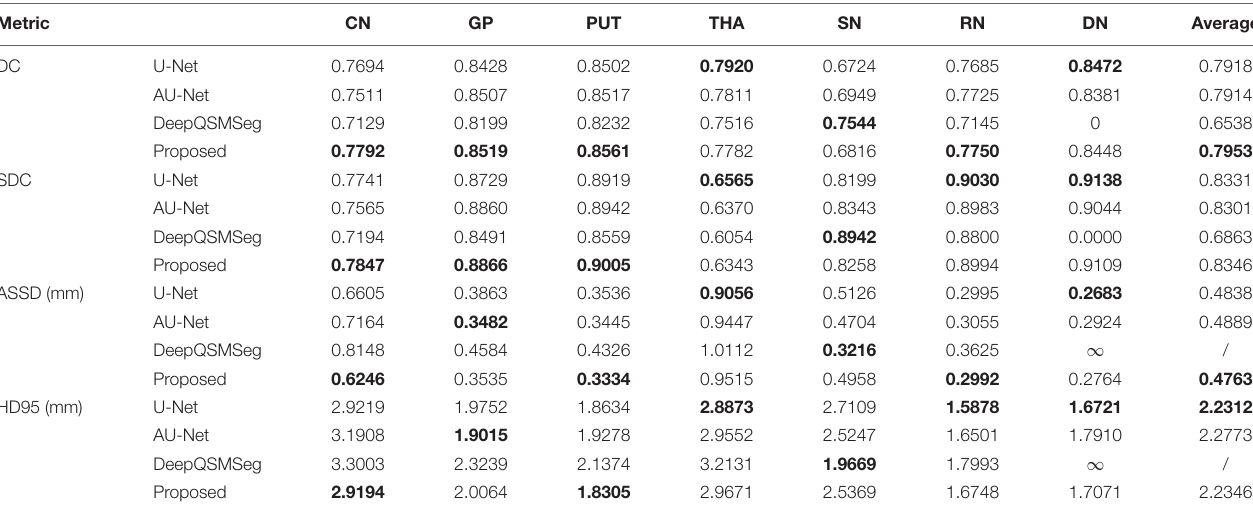
TABLE 3 | Numerical evaluation results on the Dataset II.